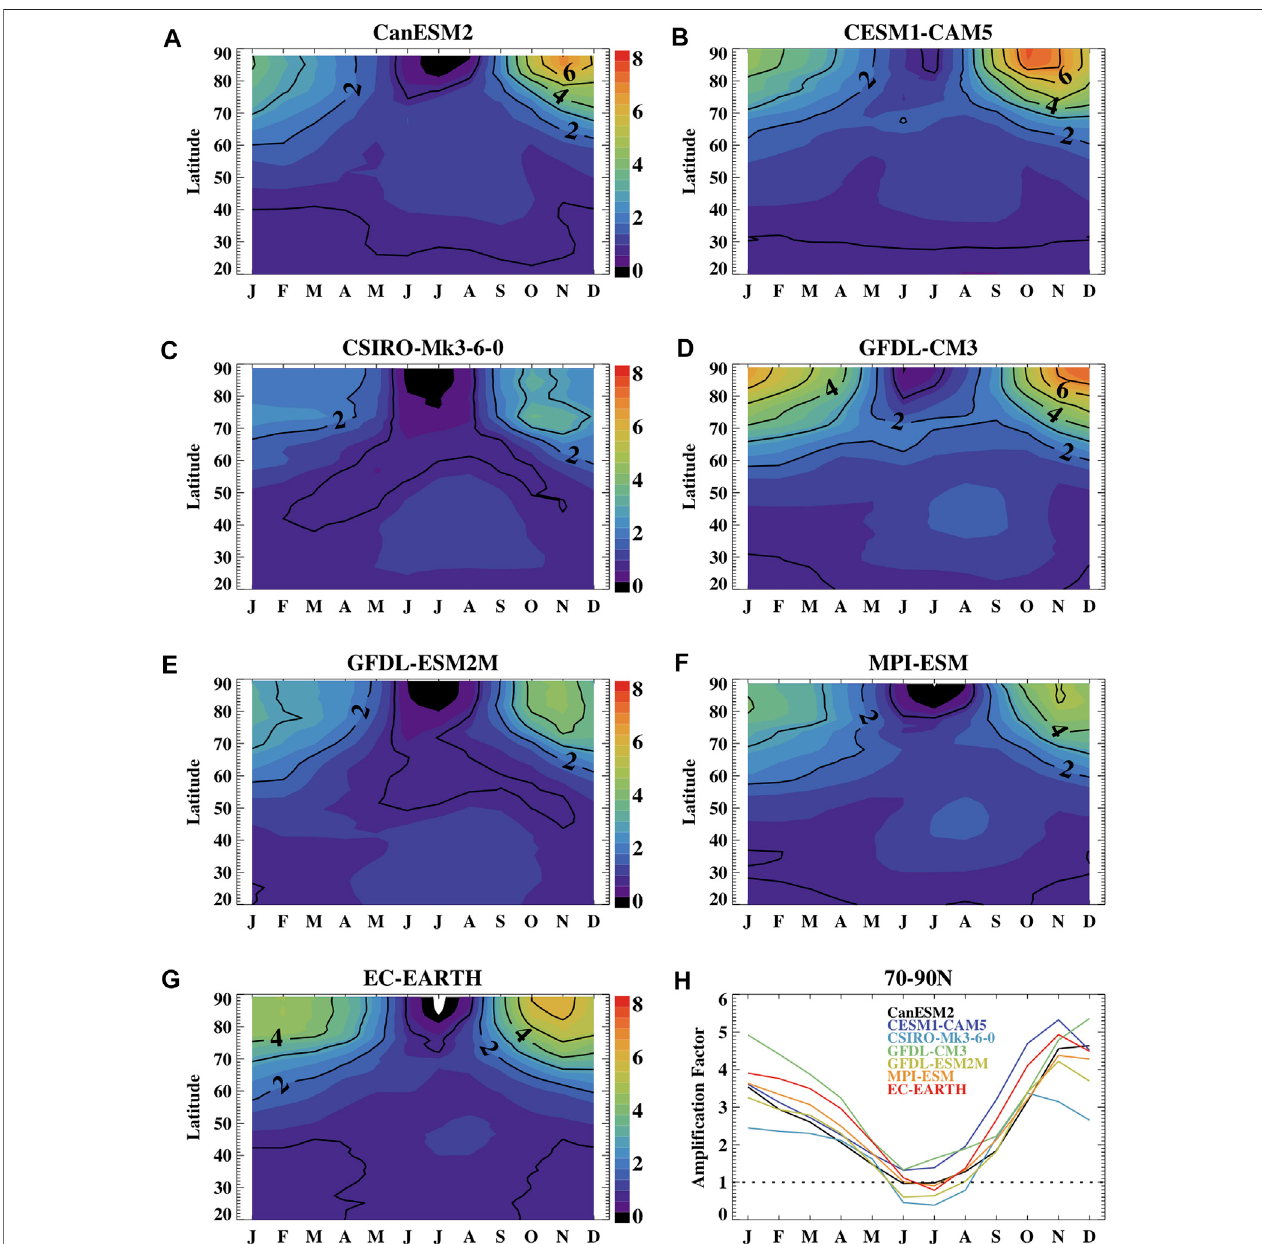
FIGURE3 | The zonalmonthlyensemble mean ampli fi cation factor at 2050asa function ofmonth and latitude for the different models including (A) CanESM2, (B) CESM1-CAM5, (C) CSIRO-Mk-3-6-0, (D) GFDL-CM3, (E) GFDL-ESM2M, (F) MPI-ESM,and (G) EC-EARTHand( fi nalpanel)the70 – 90NAmpli fi cationfactorat2050as a function of month. The lined contour interval is one. The dotted line on the fi nal panel shows a value of one for reference.